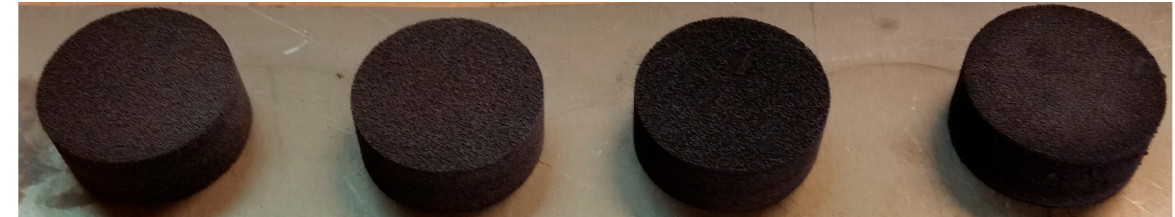
Figure 3. Calcined catalyst (from left to right: P1S1, P1S2, P1S3, P1S4).